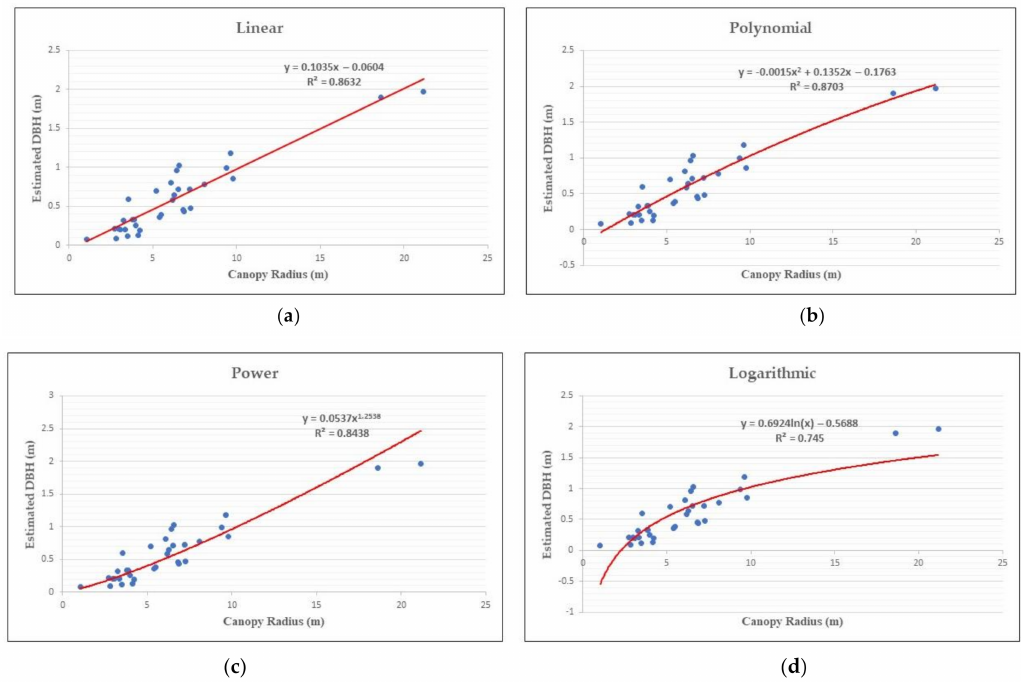
Figure 7. The regression result of DBH estimation using ( a ) linear method, ( b ) polynomial method, ( c ) power method, and ( d ) logarithmic